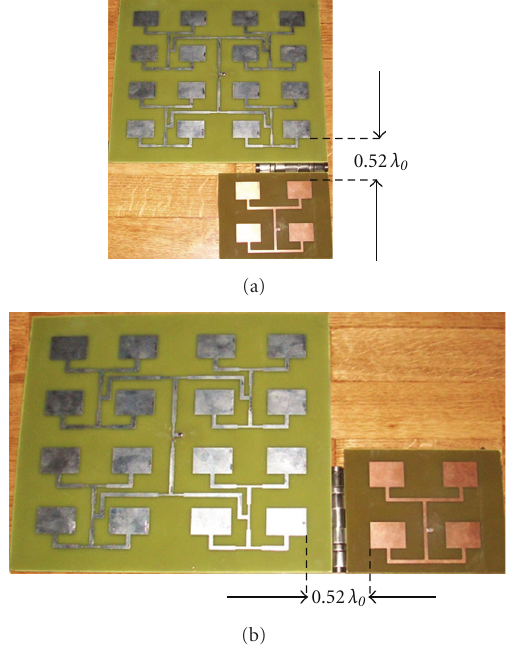
Figure 8: Antenna arrangements under test; (a) configuration 1, (b) configuration 2.